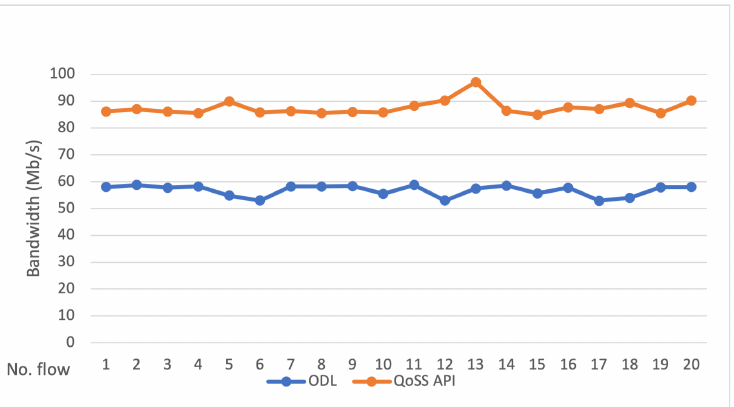
Figure 10. UDP Data transfer rate comparison. Controller default vs. QoSS API (APP_RT).